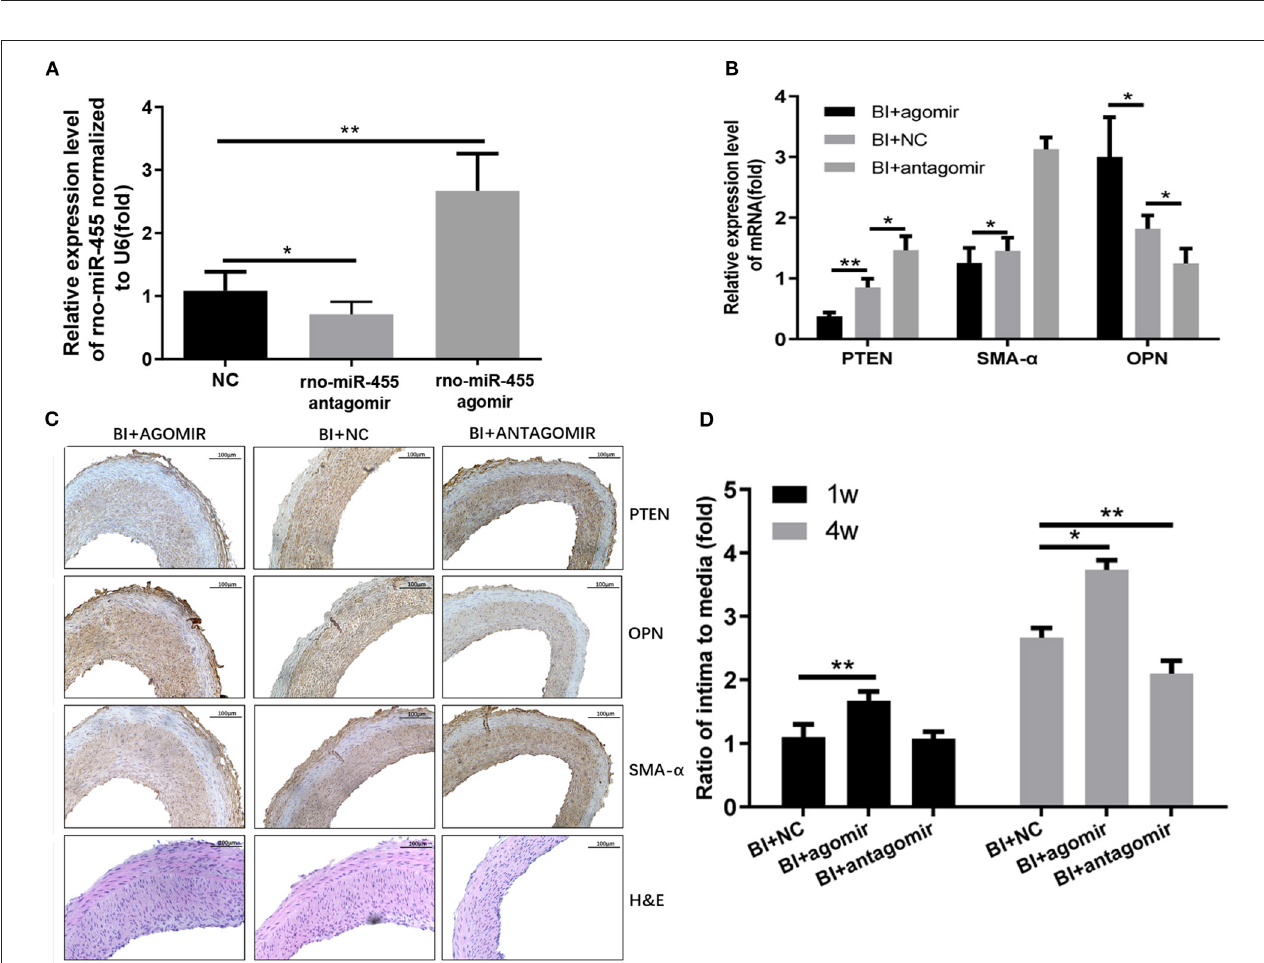
FIGURE 5 | (A) Expression levels of rno-miR-455 in uninjured and balloon-injured (BI) arteries examined by qRT-PCR. Rno-miR-455 was normalized to U6. (B) Expression levels of PTEN, SMA- α and OPN in BI arteries transfected with a negative control, rno-miR-455 agomiR or rno-miR-455 antagomiR examined by qRT-PCR. mRNA was normalized to β -actin. The values obtained from the tissue samples in the group transfected with negative control were designated as 1. (C) Immunohistochemistry of PTEN, α -SMA and OPN in BI arteries transfected with a negative control, rno-miR-455 agomiR or rno-miR-455 antagomiR. (D) The degree of neointimal formation indicated by the ratio between intima and media, measured with Image-Pro Plus 6.0 software. The value obtained from the tissue sample of first animal transfected with negative control at week 1 time point was designated as 1. * p < 0.05, ** p <